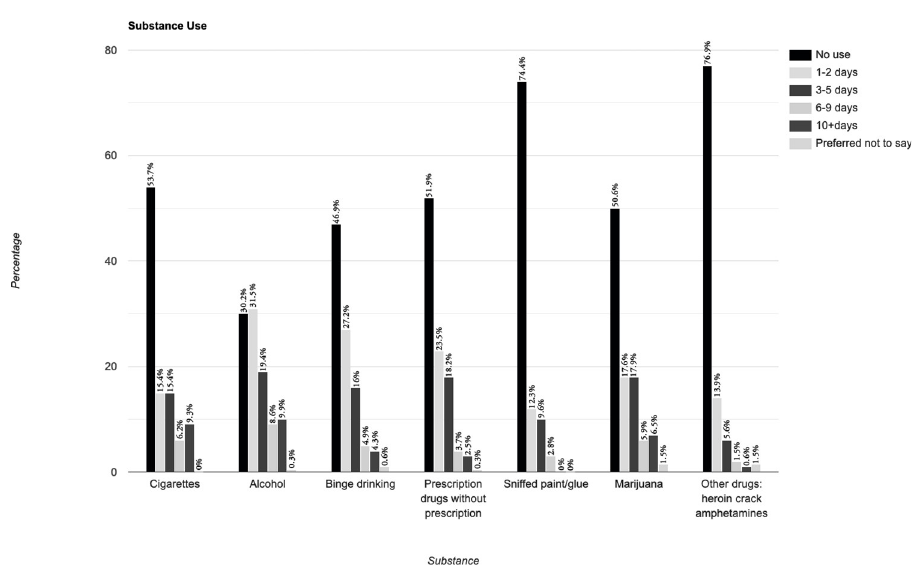
Fig 12. Substance use over the past 30